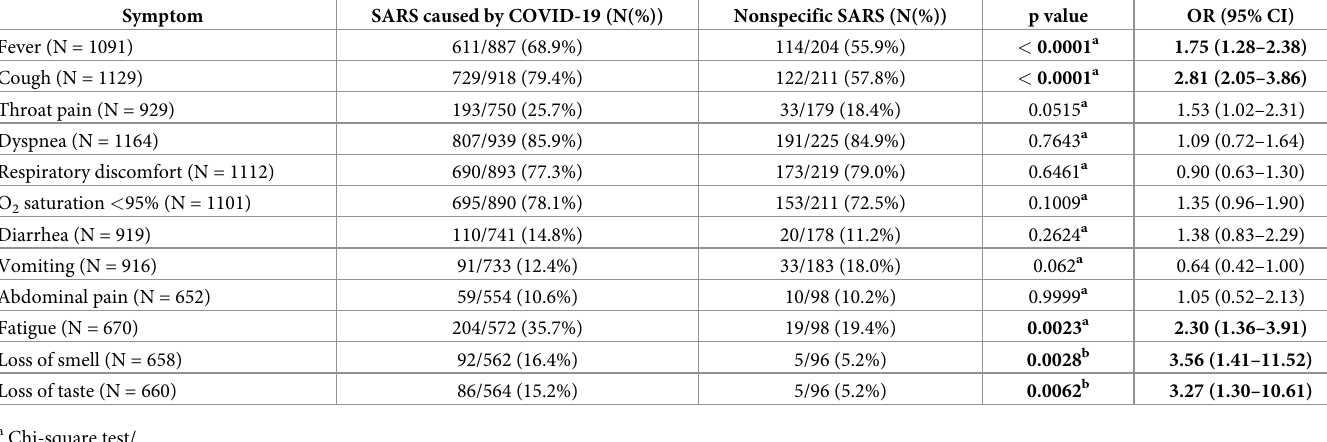
Table 3. Frequency of symptoms in pregnant and postpartum women who died from SARS according to the cause (COVID-19 or nonspecific).